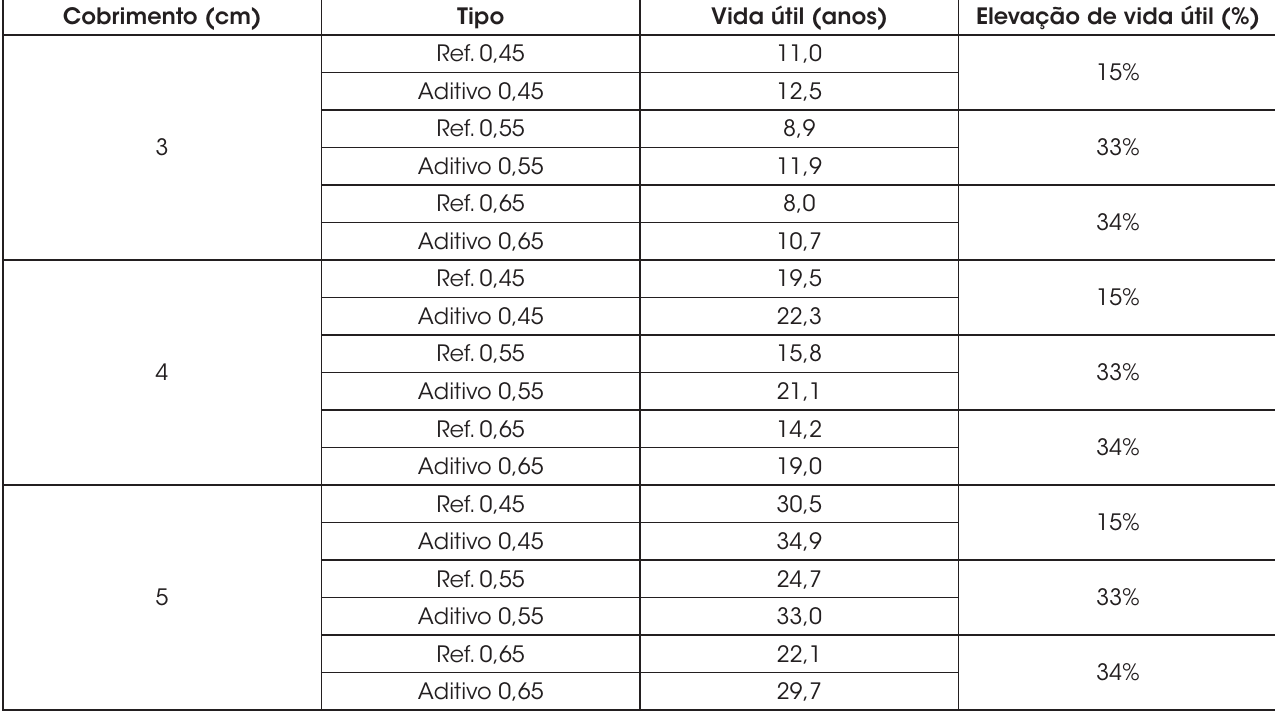
Elevação de vida útil em função da utilização do aditivo Cobrimento (cm)